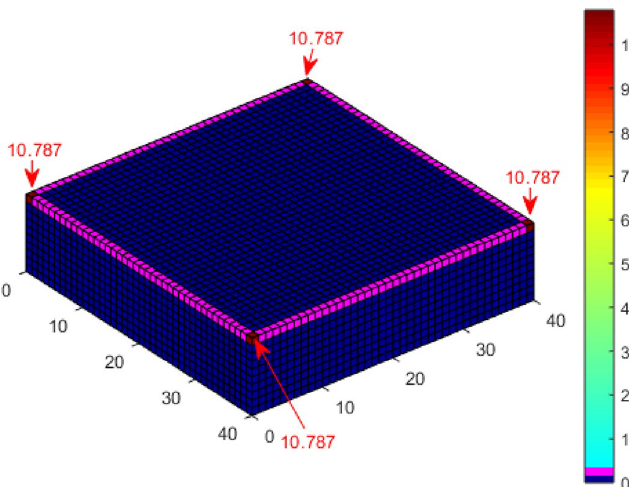
Figure 14. Lightning strike probability to a cuboid using K P2C and confined space